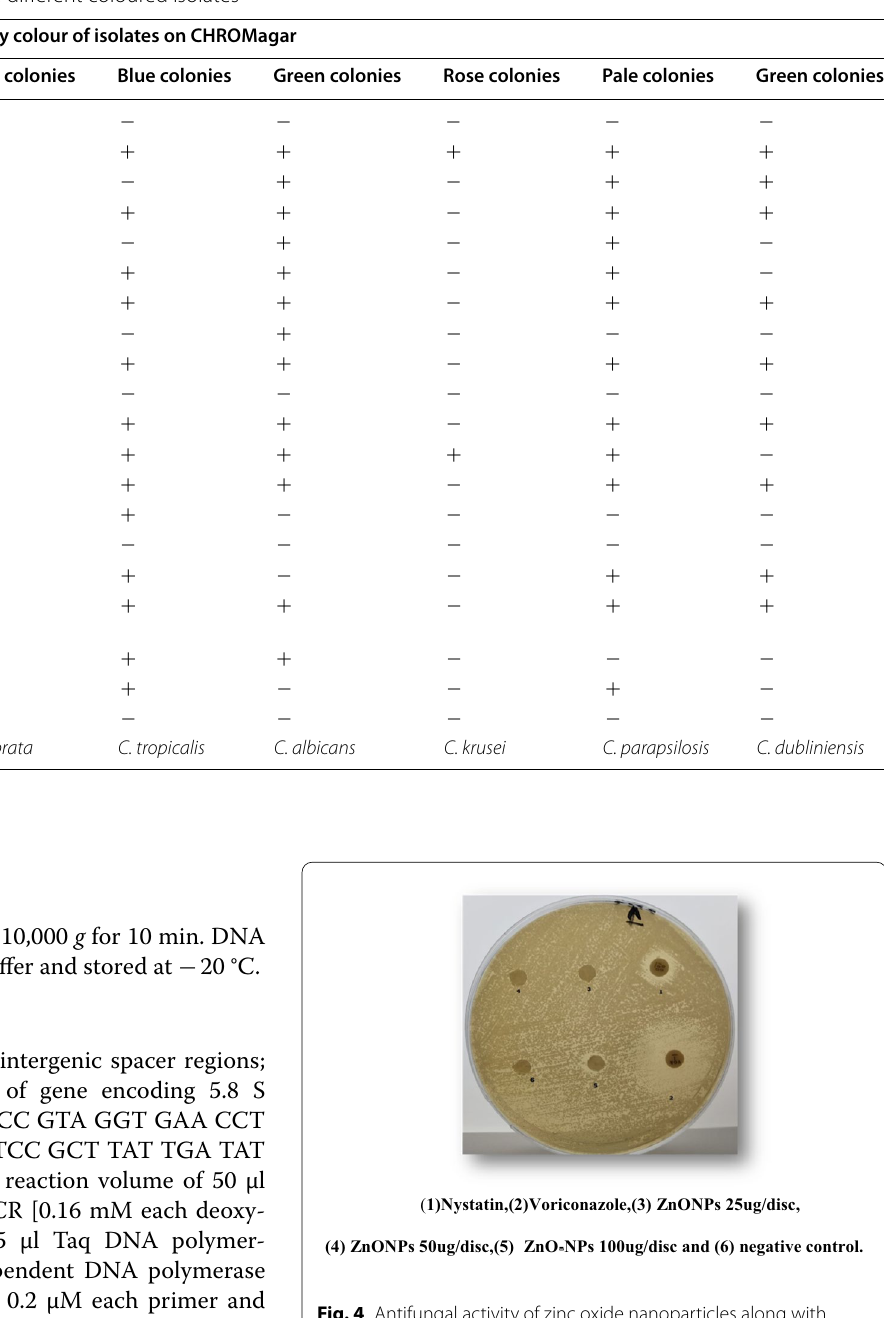
(Tris base/boric acid/EDTA). Agarose gel electrophoresis was run at 100 V and the resulting bands were visualized by UV illumination. PCR products were stored at until used (Elena et al. 2015).